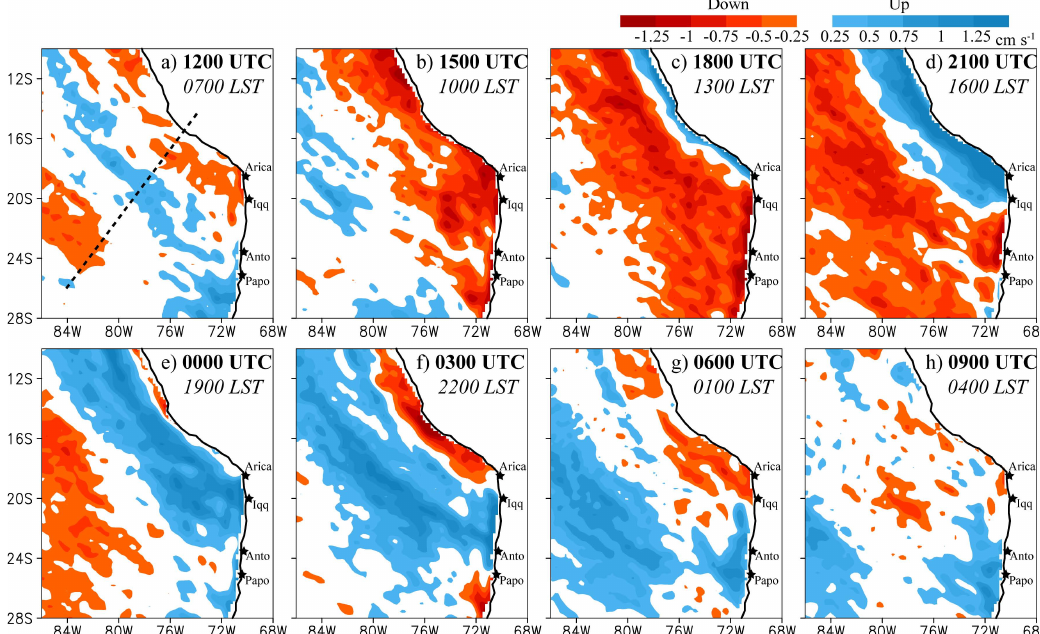
Fig. 9. WRF-simulated 2-month mean diurnal vertical velocity anomalies (cms − 1 ) at 2.5km every 3 hours. Red (blue) indicates downward (upward) motion. Dashed line in (a) depicts location of subsequent cross section. Also shown is the location of the coastal sounding stations during